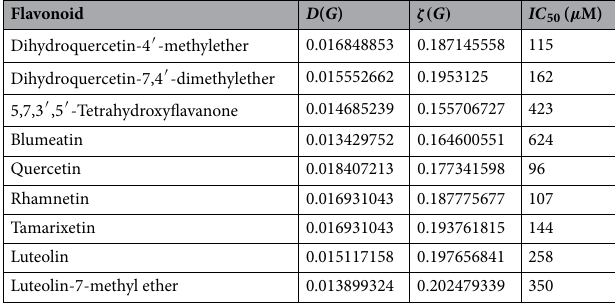
Table 1. Data for nine flavonoids.